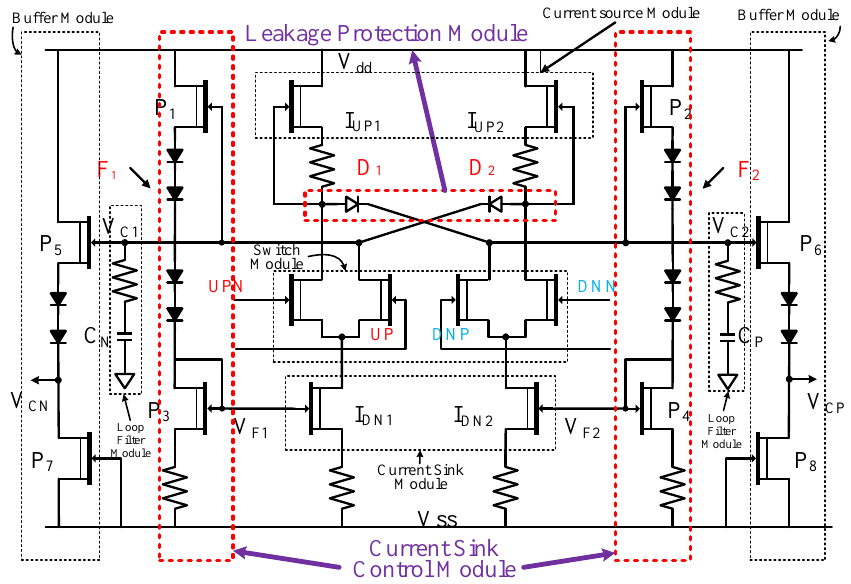
Figure 4. The structure of CP.